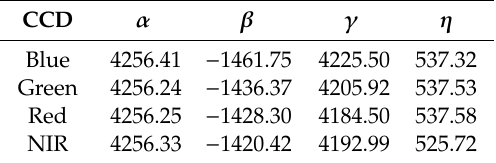
Table 7. Estimated parameters of the coordinate di ff erences due to attitude